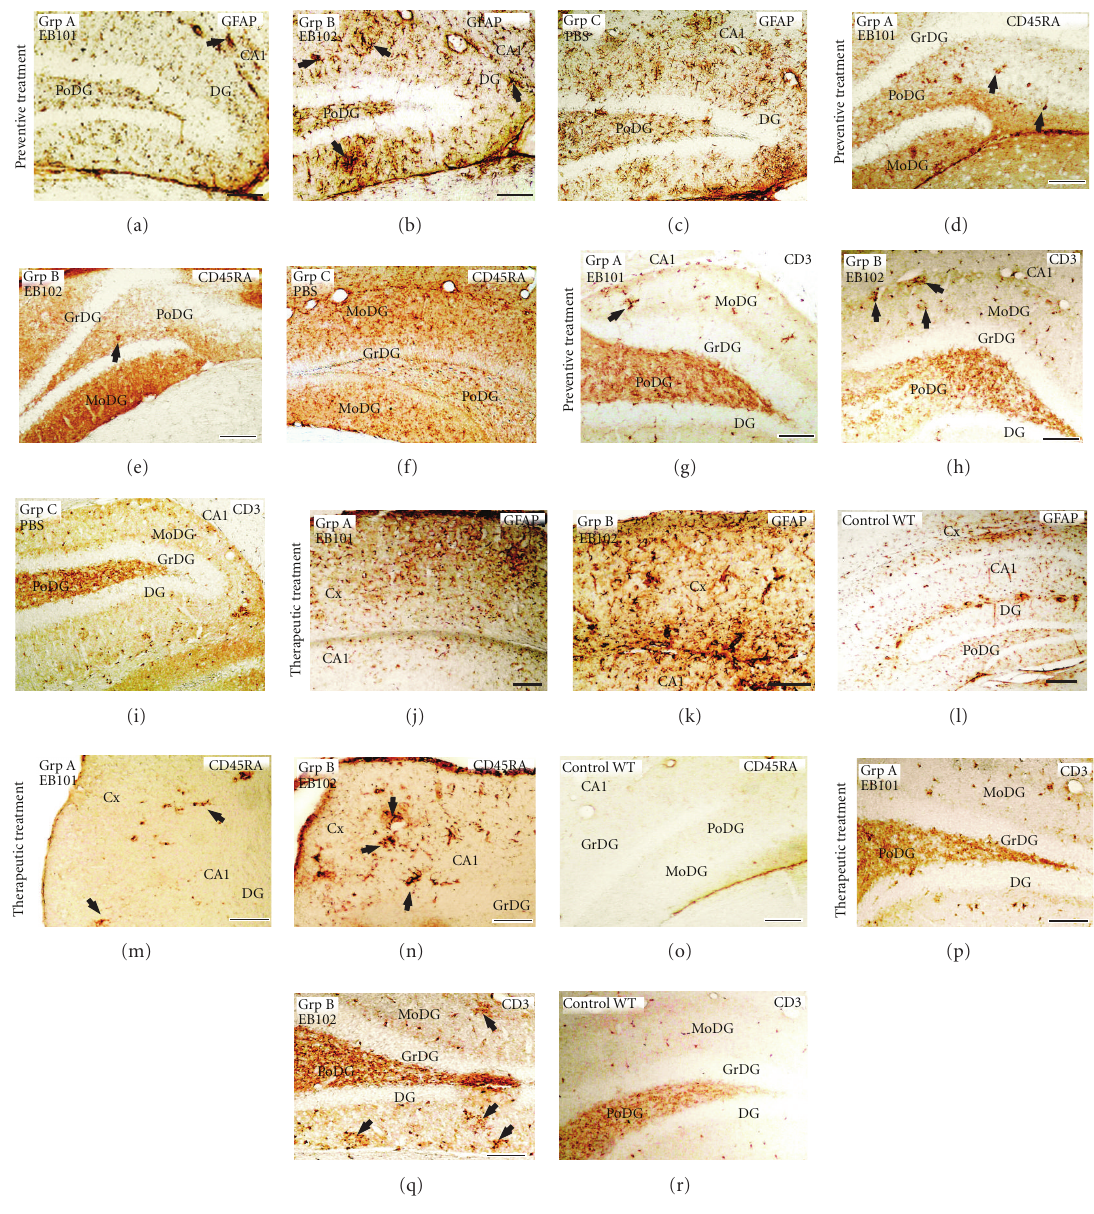
Figure 5: E ff ect of EB101 vaccine on astrocytosis and activation of B and T cells in the brains of B6C3F1/J mice. Comparative photomicro- graphs of GFAP, CD45RA, and CD3 immunoreactivity in the hippocampus ((a)–(i), (l), (o), (r)) and cortical ((j), (k), (m), (n), (p), (q)) brain regions in the preventive treatment group ((a)–(i)) and therapeutic treatment group